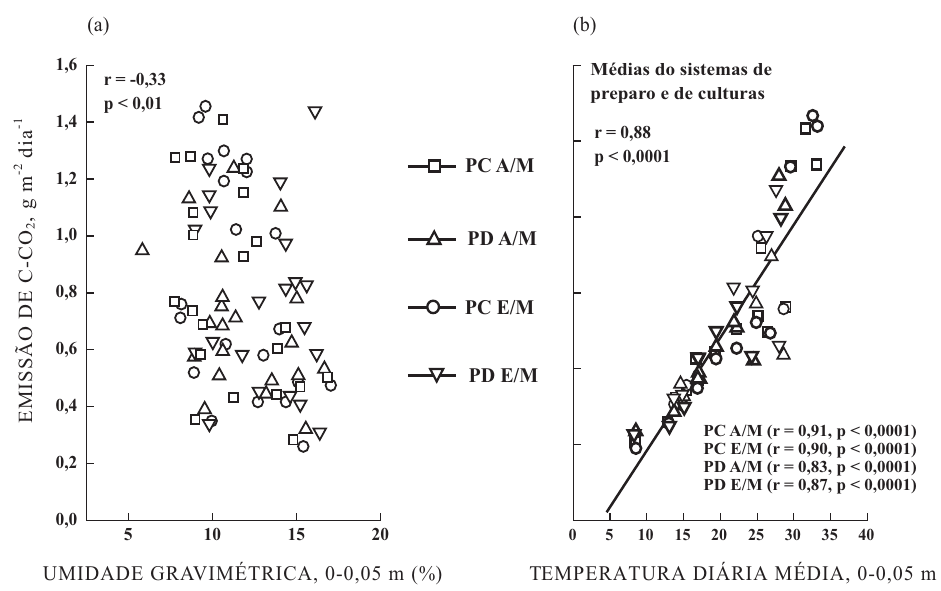
Figura 2. Emissão de C-CO do solo em função da umidade gravimétrica (a) e da temperatura do solo (b), 2 ambas na camada de 0–0,05 m do solo, no período de maio de 2003 a março de 2004. PC: preparo convencional, PD: plantio direto, A: aveia-preta, E: ervilhaca comum e M: